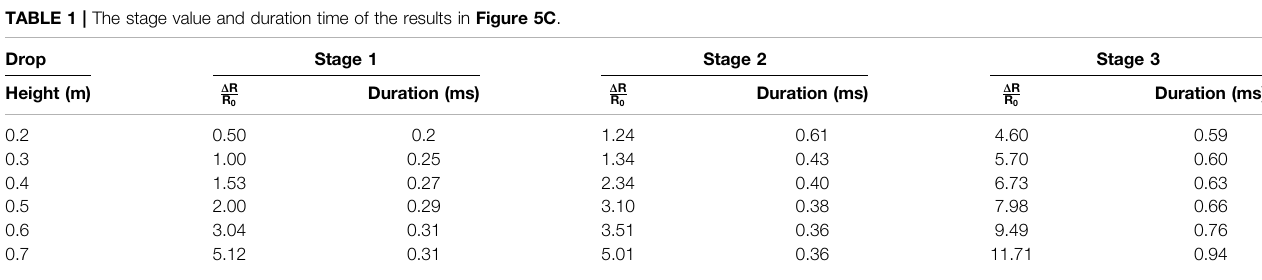
TABLE 1 | The stage value and duration time of the results in Figure 5C .